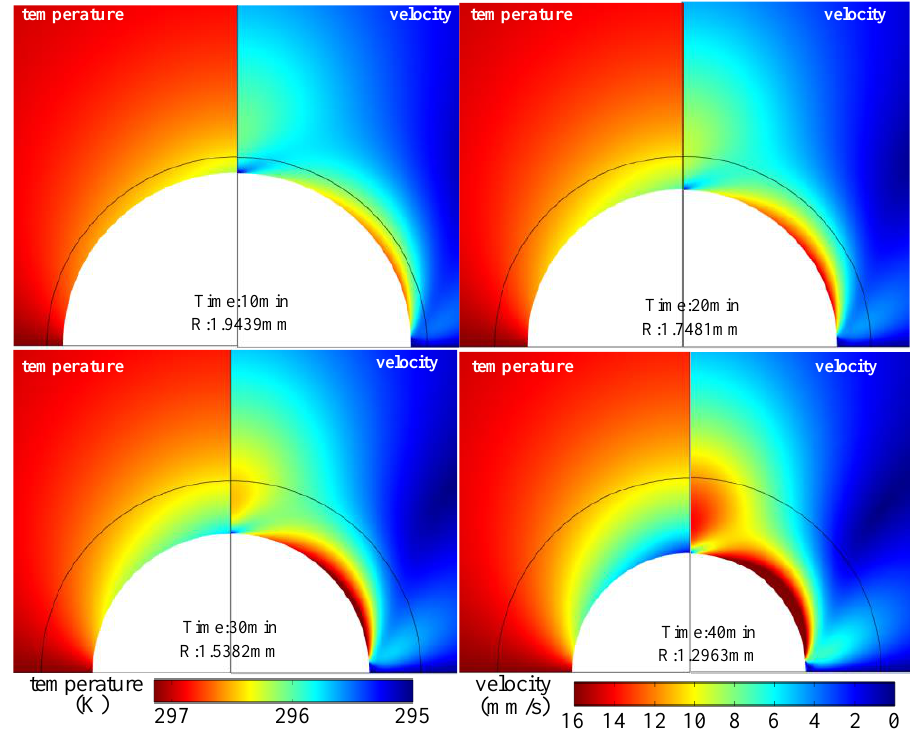
Figure 11. Distribution of temperature and velocity fields near the droplet surface as the droplet evaporates to different droplet radii. evaporates to different droplet